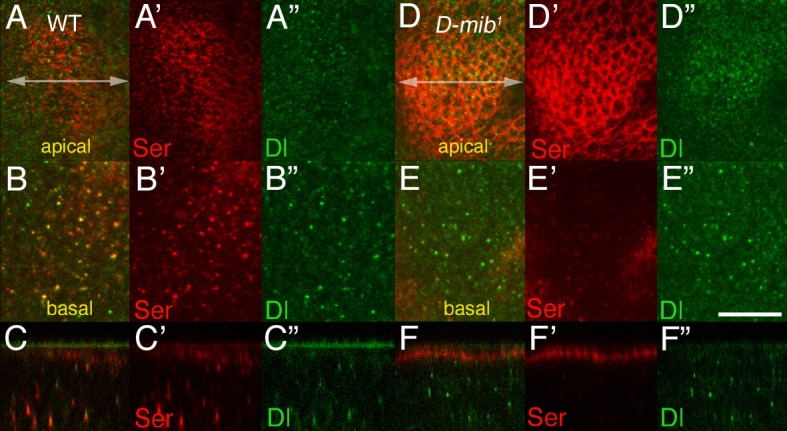
D-mib Is Required for Ser EndocytosisLocalization of the anti-Ser (red) and anti-Dl (green) antibodies that have been internalized by wild-type (A–C′′) and D-mib1 mutant (D–F′′) cells in the notum region of wing discs. (A–A′′) and (D–D′′) show apical sections and (B–B′′) and (E–E′′) show basal sections. (C–C′′) and (F–F′′) show confocal z-sections. The z-section axes are shown with a double-headed arrow in (A) and (D). Internalized anti-Ser and anti-Dl antibodies co-localized in wild-type cells. In contrast, high levels of anti-Ser antibodies were detected at the cell surface of D-mib mutant epithelial cells whereas anti-Dl antibodies were efficiently internalized.Bar is 10 μm for all panels.